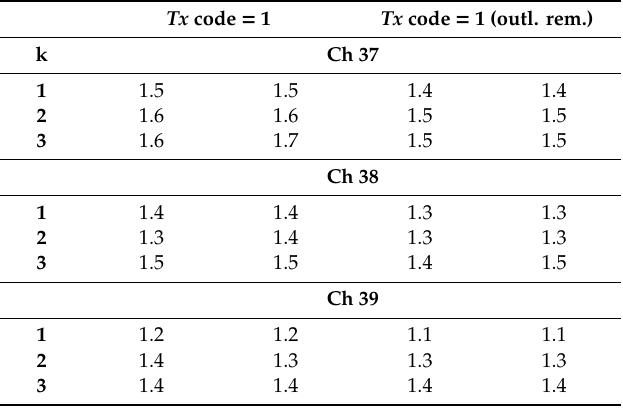
Table 22. Comparison of accuracies (in m) for Tests #4 and #8. For each option, the first and second data columns refer to the iBeacon and Eddystone protocol respectively. The three advertising channels are referred to as Ch 37, etc., and the number of neighbors in the WKNN algorithm, as k . Tx code = 1 Tx code = 1 (outl. rem.)